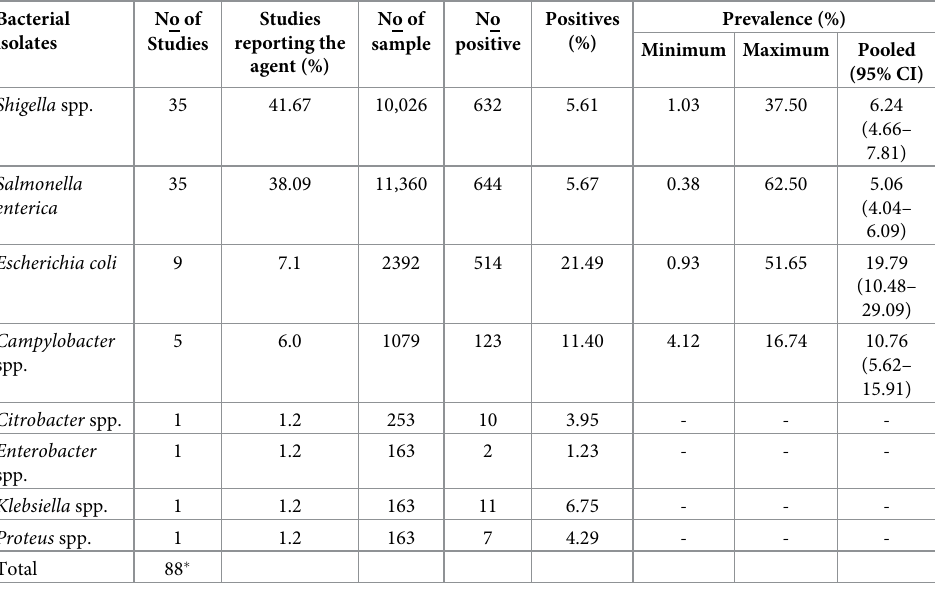
Table 3. Bacterial isolates reported by published articles from diarrheic patient. Bacterial